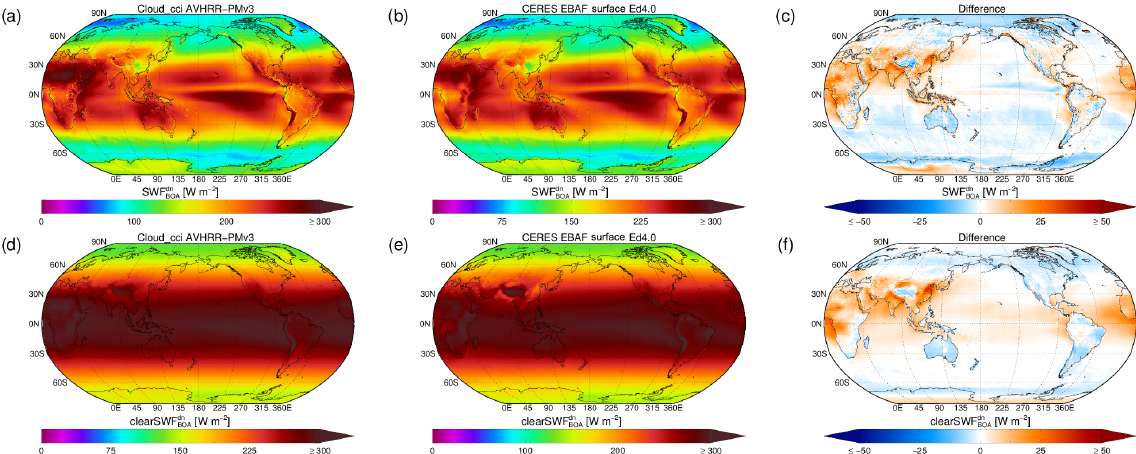
Figure 6. Multi-annual (2003–2016) mean downwelling shortwave (SW) radiative fluxes at bottom of atmosphere (BOA) for all-sky con- ditions for Cloud_cci AVHRR-PMv3 (a) and CERES EBAF surface fluxes (b) . Panels (d) and (e) show the same data but for clear-sky conditions. Panels (c) and (f) show difference plots Cloud_cci minus CERES.